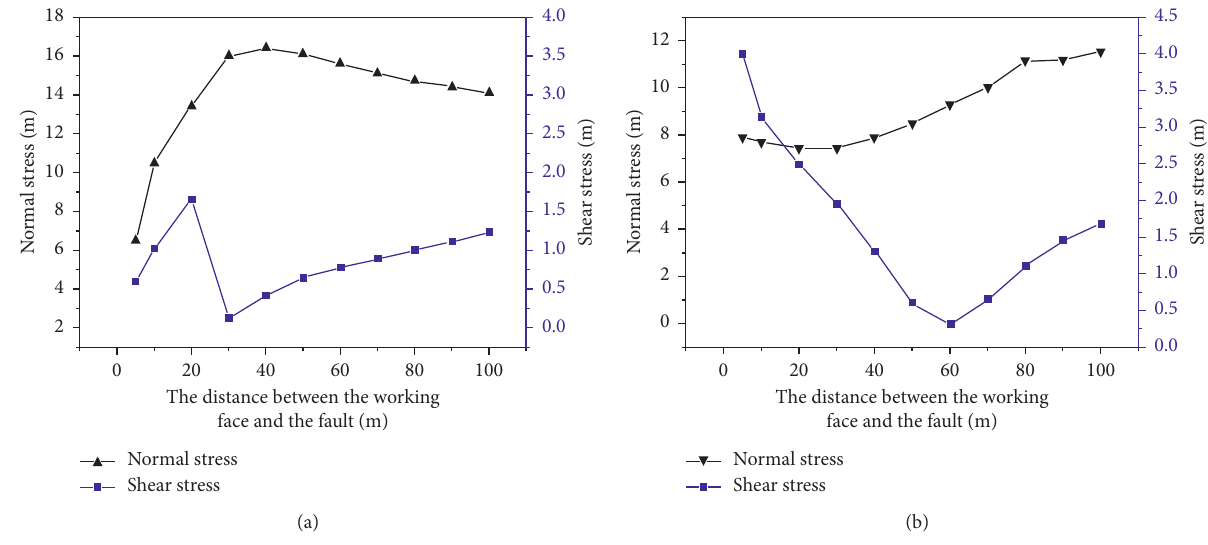
Figure 13: Stress variation in the fault plane in footwall mining. (a) Point A ′ . (b) Point B ′ .